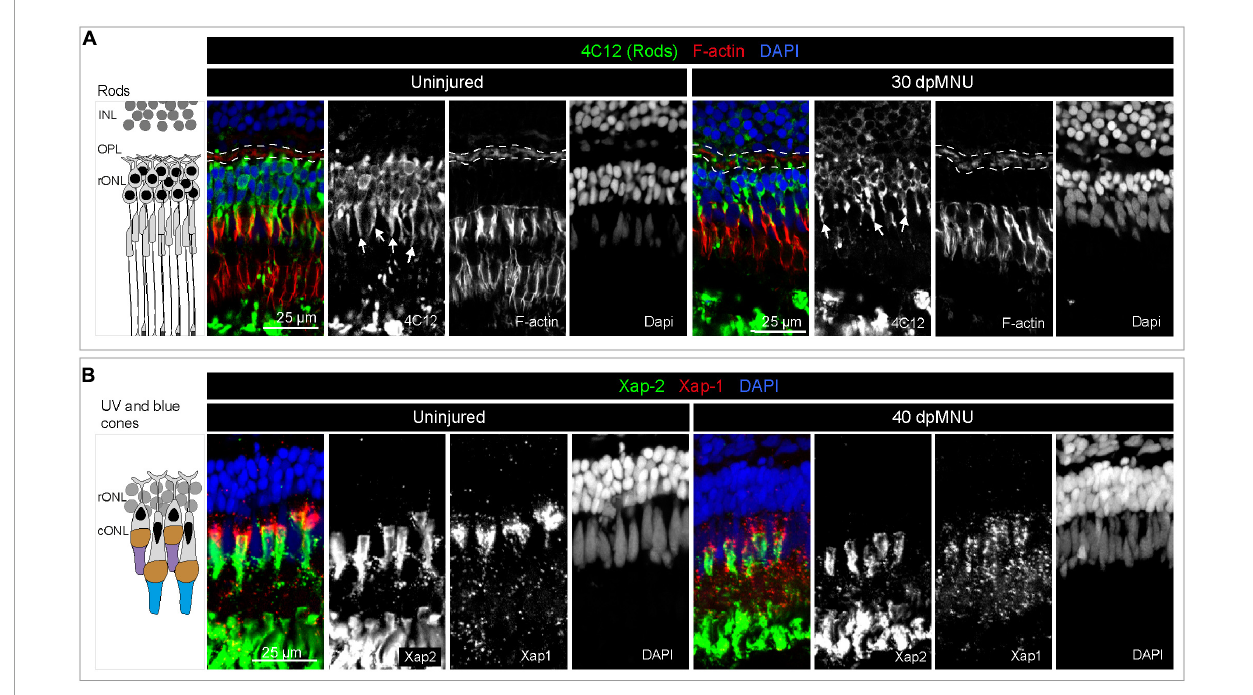
FIGURE4 Restoration of rods and UV cones after MNU-injury. (A) Schematic illustration and sections of intact and 30 dpMNU retinas immunostained against the rod marker 4C12 (green), the F-actin marker Phalloidin (red) and DAPI (blue). The distribution of rods (4C12, green) and synaptic processes of the OPL (encircled with a dashed line) are restored at 30 dpMNU. (B) Schematic illustration and sections of intact and 40 dpMNU retinas immunostained with Xap-2 (green), Xap-1 (red) antibodies, and DAPI (blue). The outer segment of UV-cones is restored at 40 dpMNU. INL, inner nuclear layer; OPL, outer plexiform layer; rONL, rod outer nuclear layer; cONL, cone outer nuclear layer. N =